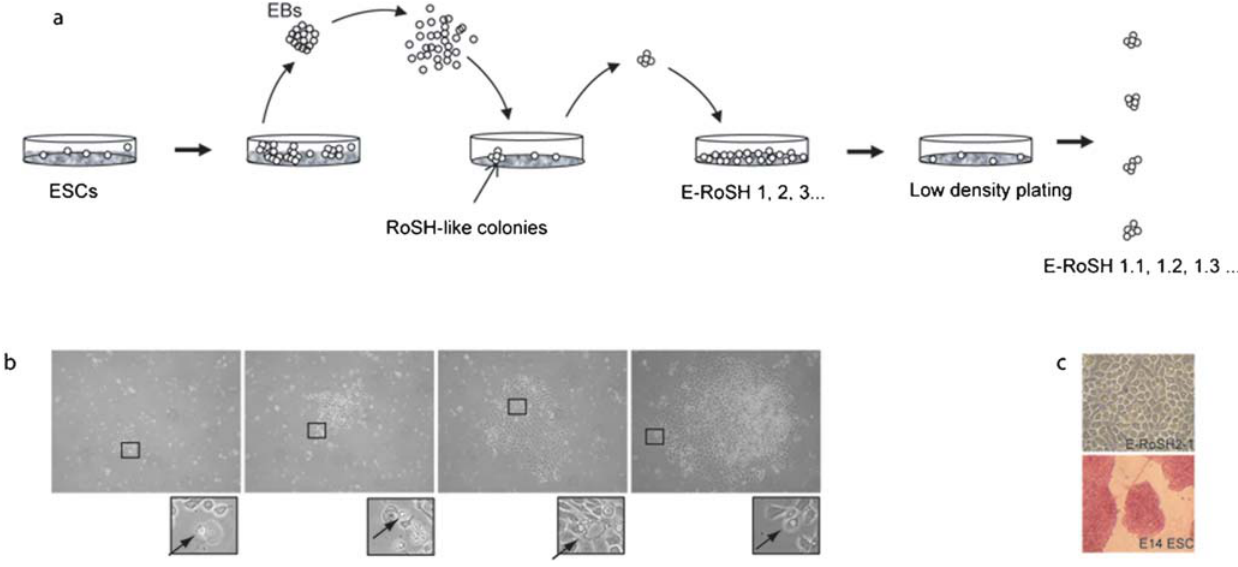
Figure 1. Derivation of E-RoSH cell lines. (a) ESCs were plated singly on methycellulose based media to form EBs. At day 3–6, EBs were harvested, dissociated by collagenase and cultured as a monolayer on gelatinized feeder plate. RoSH-like colonies with adherent fibroblast-like cells and ring-like structures were selected and propagated on gelatinized plates to generate E-RoSH 1, 2, 3… Each of the cultures were then plated at a low density of 10–100 cells per 10 cm plate and single RoSH like colonies were picked to established sublines, E-RoSH 2.1, 2.2, 2.3. .. etc; b) A putative RoSH-like colony consisting of adherent short fibroblast-like cells with characteristic ring-like cells (inset) expanding over time; c) Alkaline phosphatase staining of E-RoSH2.1 and its parental E14 ES